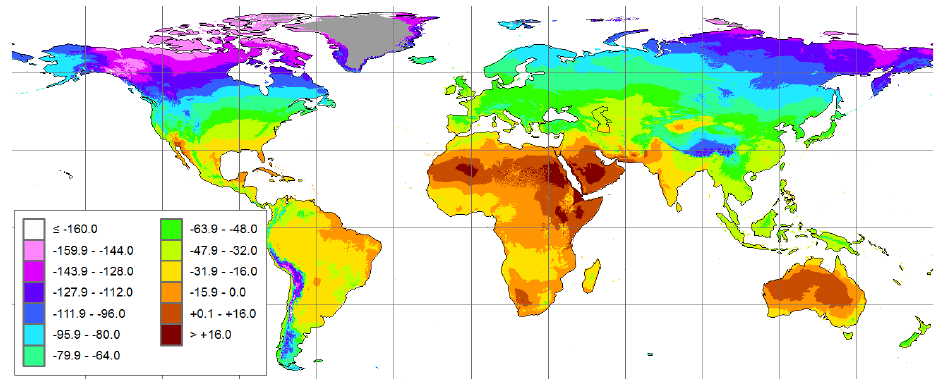
Fig. 14. Predicted amount-weighted mean growing-season δ 2 H GS in precipitation obtained using RCWIP. Growing season was defined as the mean of all months where the average air temperature was >0 ◦ C. Legend is δ 2 H in ‰, relative to VSMOW-SLAP scales.